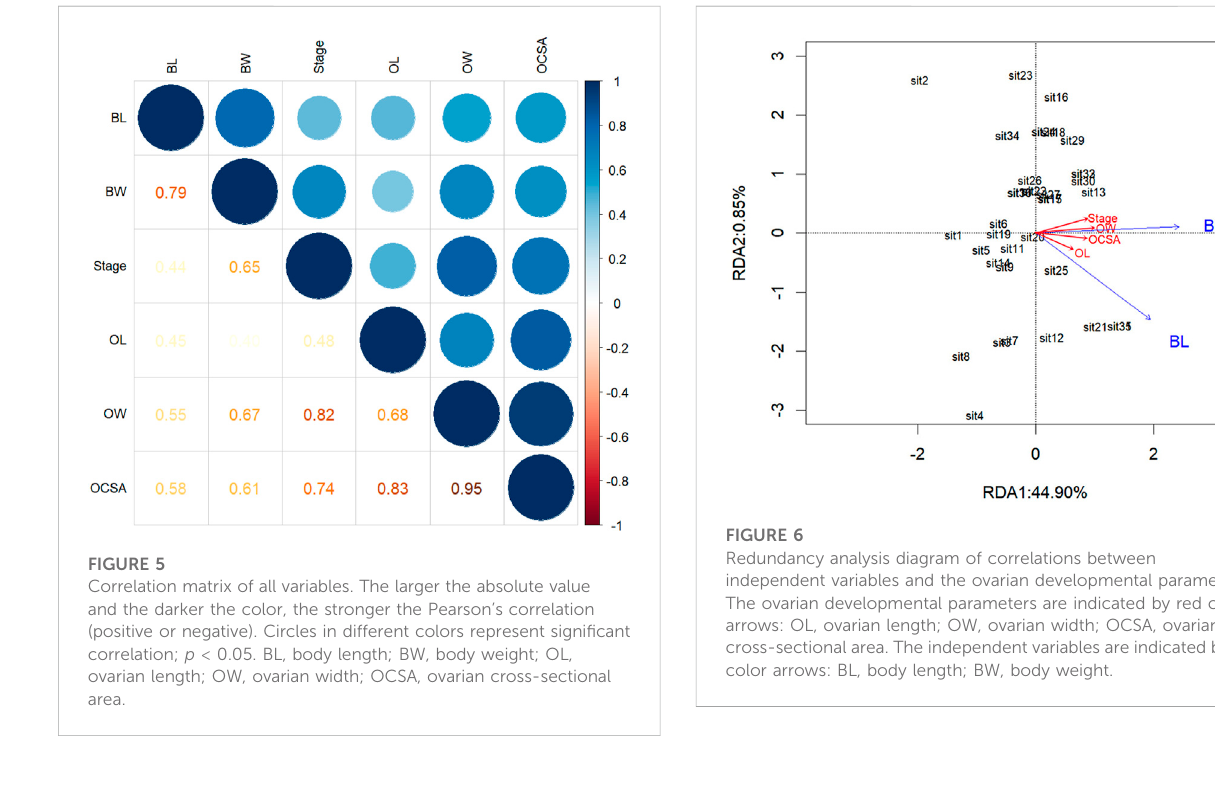
TABLE 2 Forward selection results with the test of variable signi fi